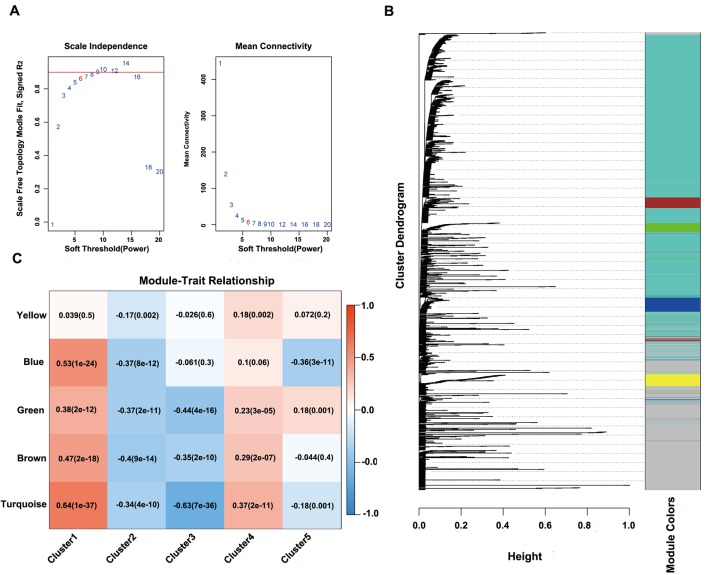
WGCNA analysis of CpG sites. (A) Scale-free topology index and mean connectivity were used to determine the soft threshold (â = 6). (B), Clustering dendrogram of CpG sites. The dissimilarity of CpG sites is based on topological overlap. The genes are assigned to different modules and are identified using different colors. (C) Module–trait correlation analysis showed that five modules were significantly correlated with each cluster.